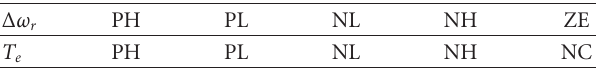
Table 1: Fuzzy rule-based